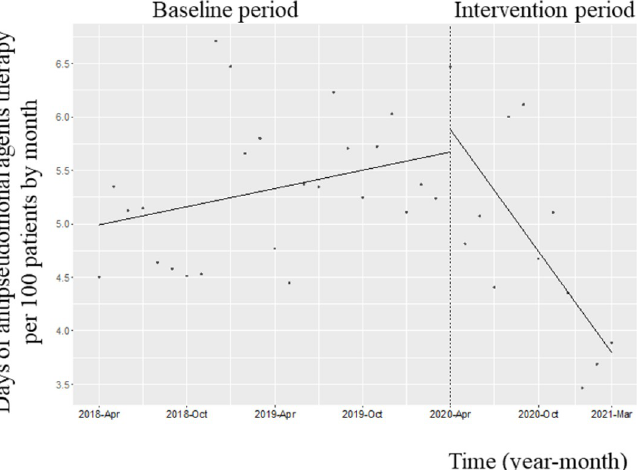
Fig 2. Trends in the days of antipseudomonal agent (piperacillin–tazobactam, cefepime, and cefozopran) therapy per 100 patients, by month, during Phase 2 of the intervention period. Each dot refers to the days of antipseudomonal agent therapy per 100 patients in each month, and the slope is based on linear regression in the two phases. The explanation of each phase is as follows: Phase 1 (antimicrobial notification by the infection control team from April 1, 2018, to March 31, 2020); Phase 2 (establishing an infectious disease [ID] consultation service and implementation of the Antimicrobial Stewardship Program [ASP] from April 1, 2020, to March 31, 2021). The level of the monthly DOT of the three antipseudomonal agents did not decrease (coefficient: 0.20; 95% confidence interval [CI]: − 0.67 to 1.09, p = 0.65), although the trend decreased (coefficient: − 2.22; 95% CI: − 0.33 to − 0.10, p < 0.001).